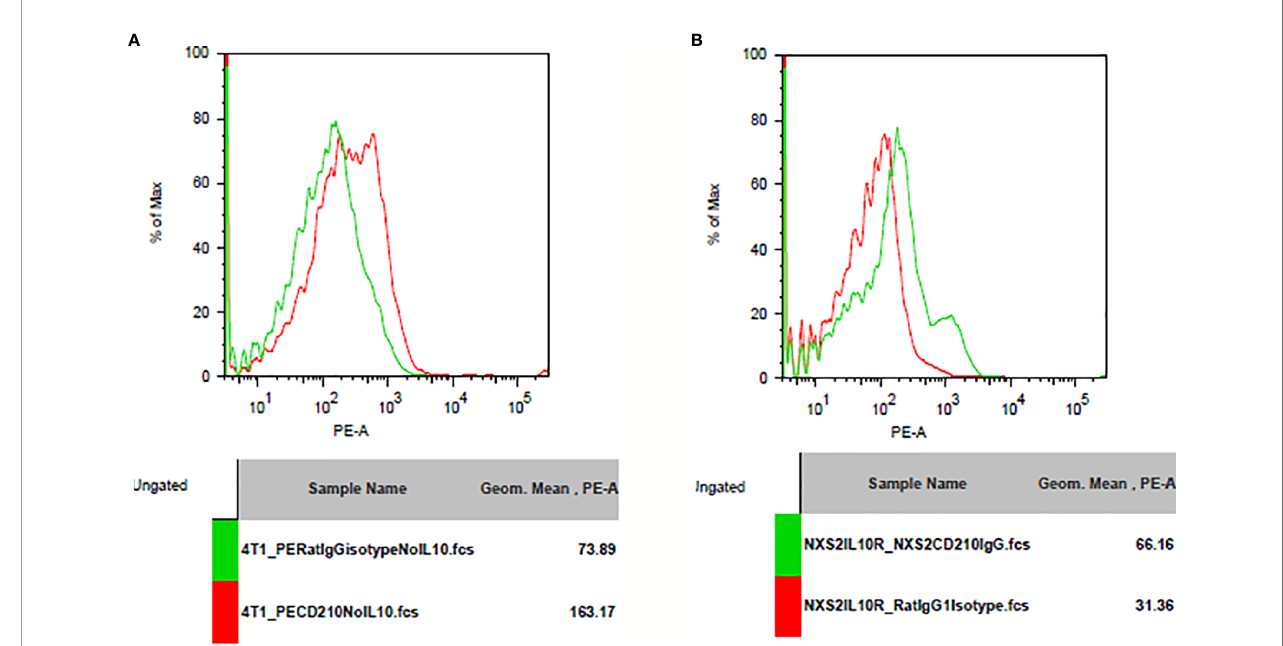
FIGURE 7 | IL-10 receptor expression on 4T1 or NXS2 cells. (A) IL-10 receptor(CD210) expression on 4T1 cells. There was strong CD210 expression on 4T1 cells compared to isotype control. (B) IL-10 receptor(CD210) expression on NXS2 cells. There was strong CD210 expression on NXS2 cells compared to isotype